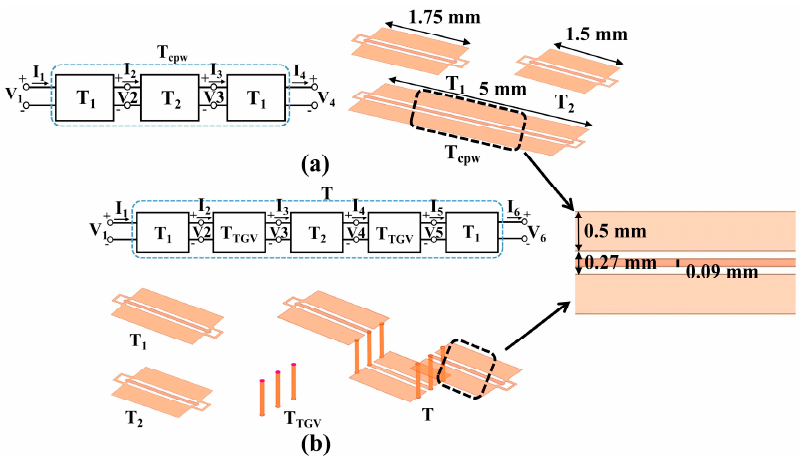
Figure 2. Schematic representation of measure structures needed to perform S-parameter extraction. ( a ) Simulation model of the CPW series without TGVs, ( b ) The CPW series simulation model incorporating TGVs.